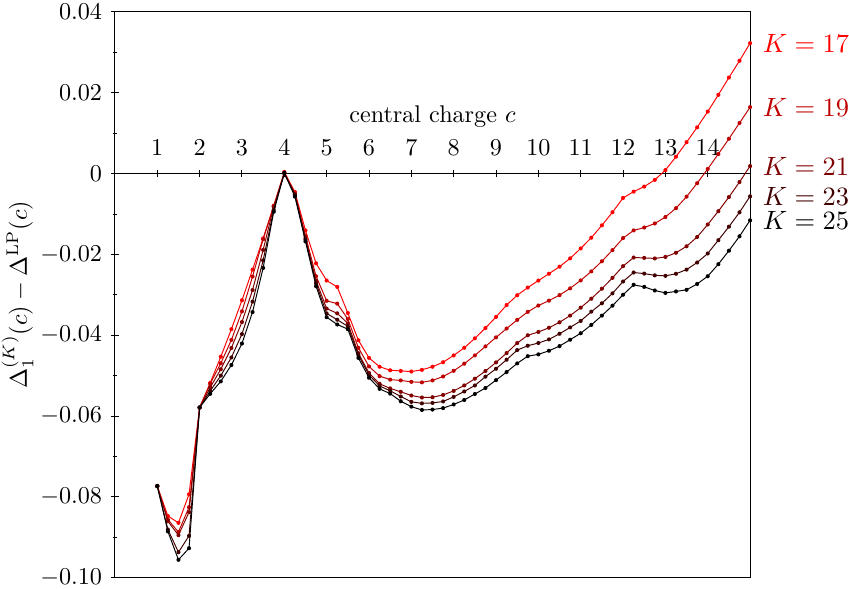
Figure 3 . Comparison of the spinning bootstrap to the spinless bootstrap bound ∆ LP ( c ) .